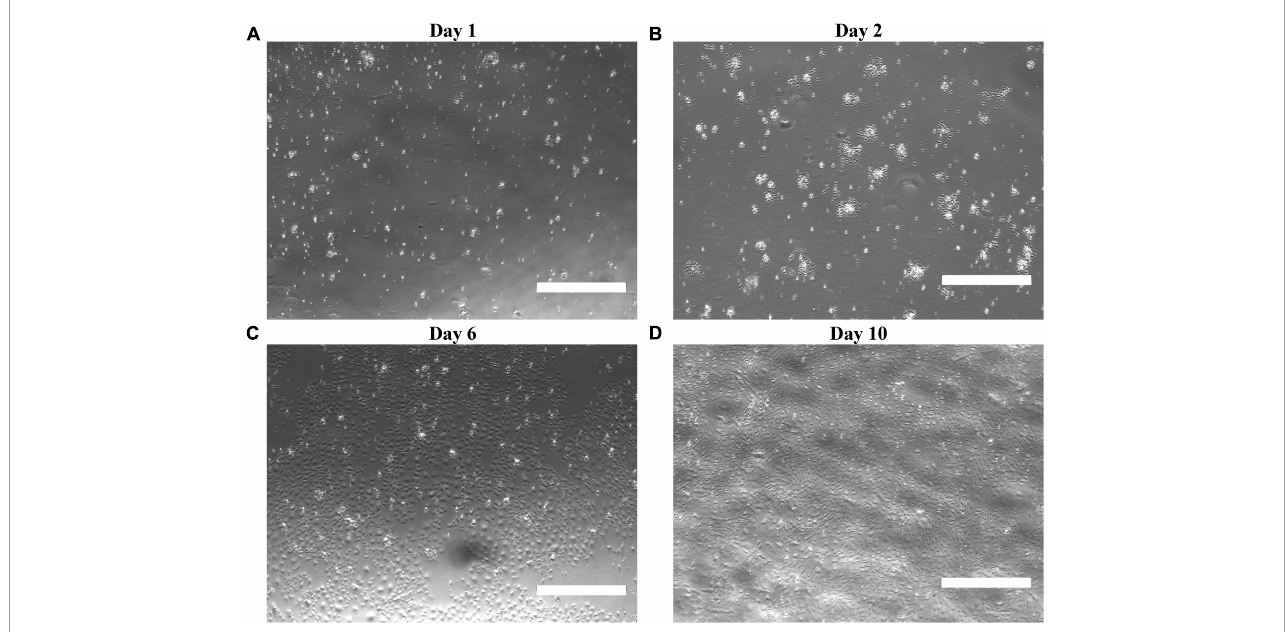
FIGURE2 Characterization of isolated MRPECs outgrowth and morphology in monoculture. Representative phase-contrasted photomicrographs of MRPEC monoculture, outgrowth, and morphology at various post-isolation time points. MRPECs monoculture, outgrowth, and morphology at (A) 1 day post-isolation, (B) 2 days post-isolation, (C) 6 days post-isolation, and (D) 10 days post-isolation. N = 3–5/time point. Scale bars, 750 µ